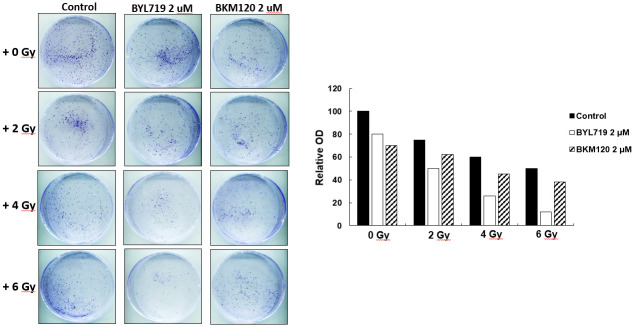
IR exposure combined with BKM120 or BYL719 treatment dose-dependent reduced cell growth in OSCC cells.SCC25 cells were pretreated with BKM120 or BYL719 at 2 μM and then irradiated at 0, 2, 4 or 6 Gy. After 14 days, colonies were stained with crystal violet and quantified by an ELISA reader. Data are presented as mean ± SD, and the asterisks indicate significant difference. *P < 0.01 compared with the control group.